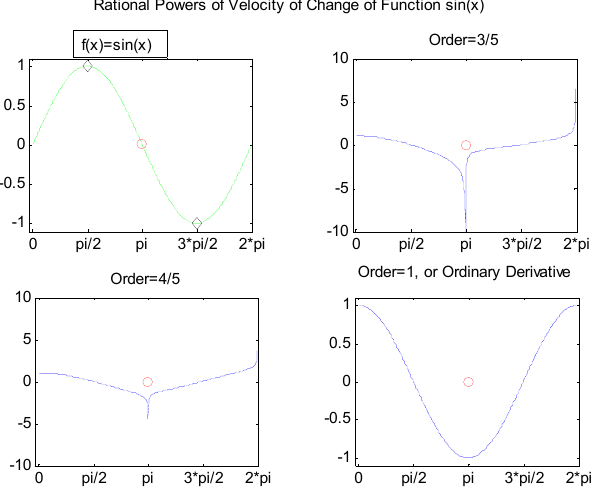
Figure 2. The rational orders of rates of change for the sine function (Orders are 0, 1/5, 2/5).